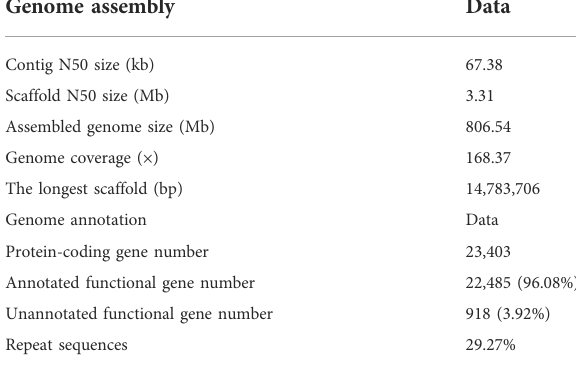
TABLE 1 Summary of the genome assembly and annotation for Southern blue fi n